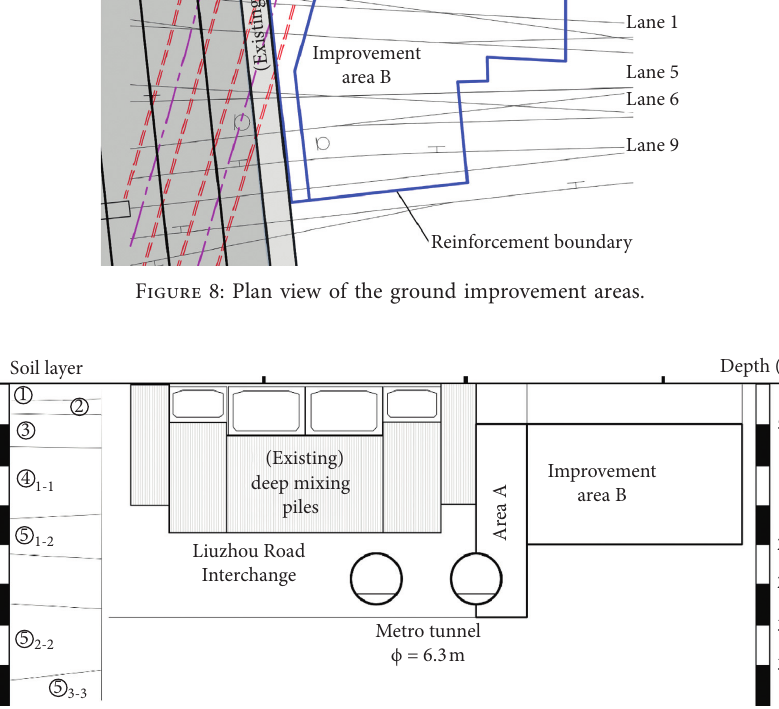
Figure 9: Cross-section view of the ground improvement areas. Table 5: Material composition of tail-void